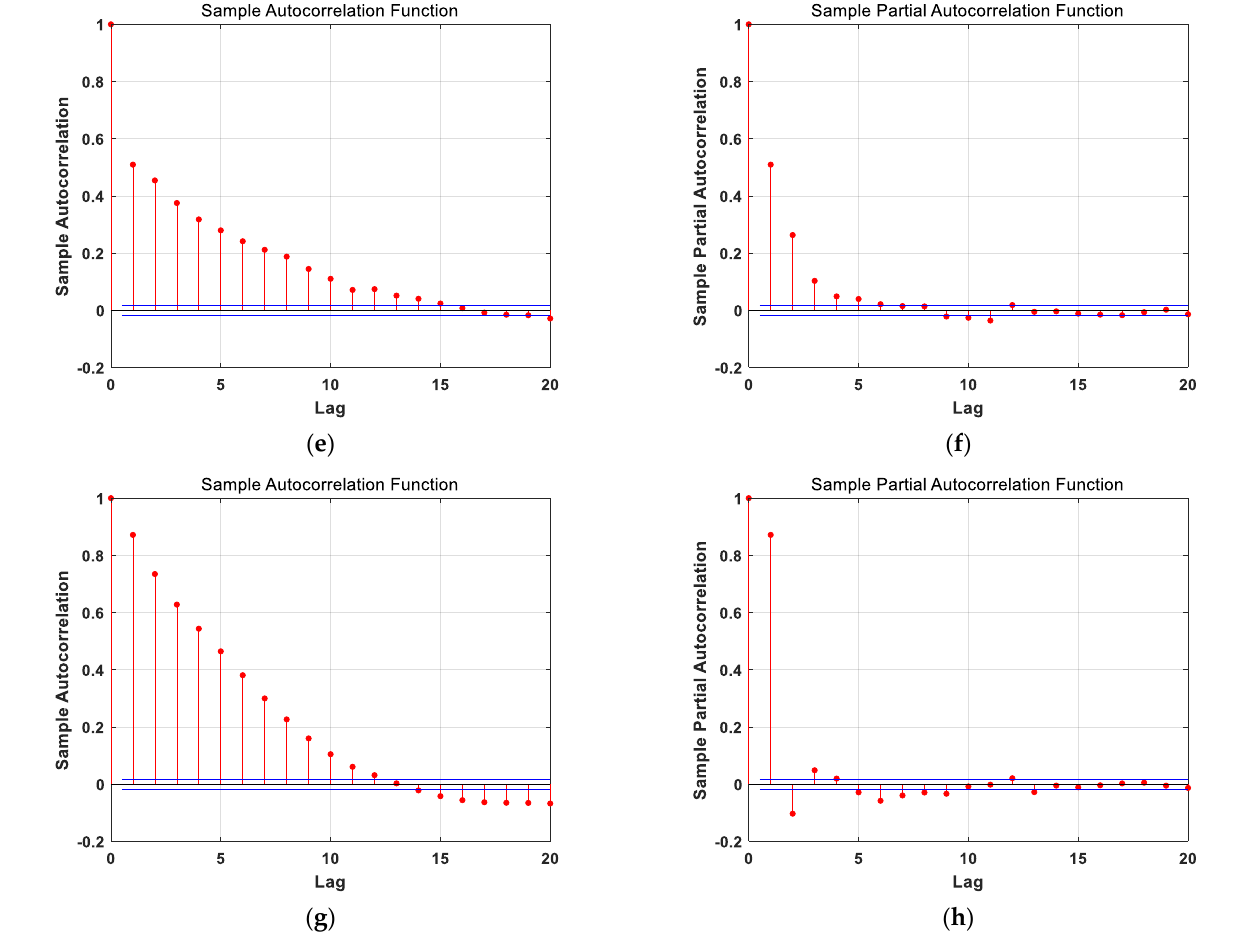
Figure A1. Autocorrelation function and partial autocorrelation function diagram. ( a , b ) x -axis raw data, ( c , d ) x -axis BiLSTM network results, ( e , f ) z -axis raw data, and ( g , h ) z -axis BiLSTM network results.